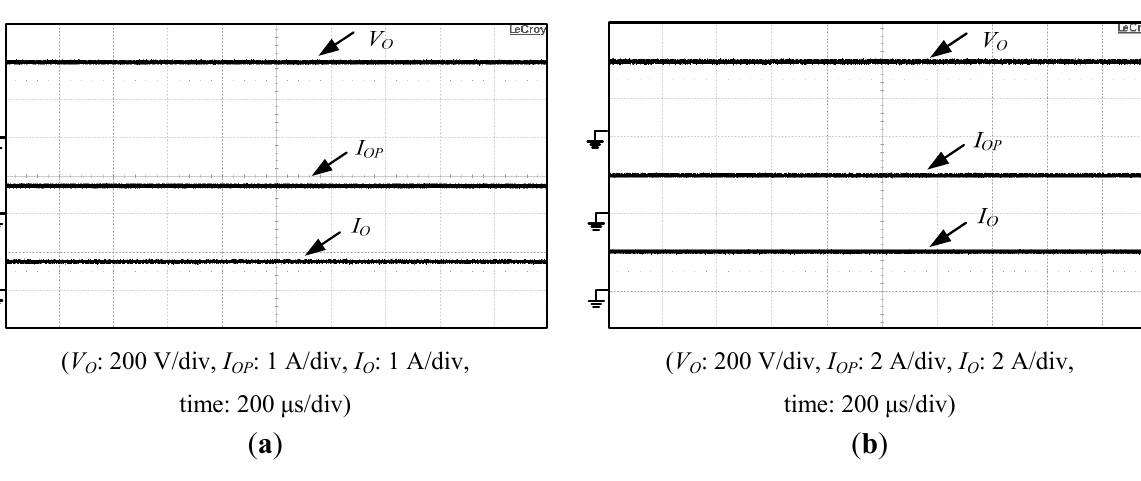
Figure 33. Measured voltage V system operated in mode VI ( a ) under P